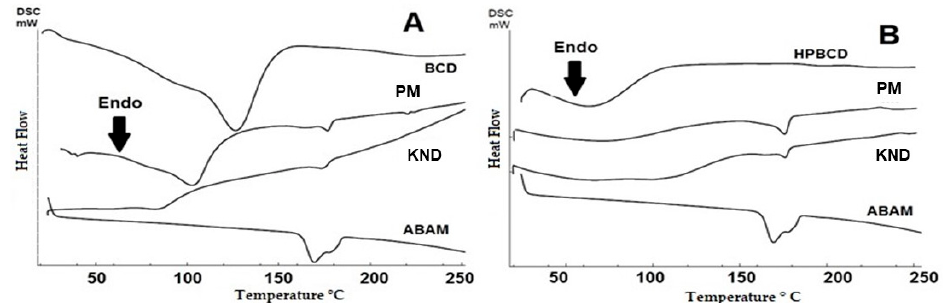
Figure 5. Differential scanning calorimetry (DSC) curves for ABAM, CDs and their respective ICs obtained with β CD ( A ) and HP β CD ( B ) by PM and